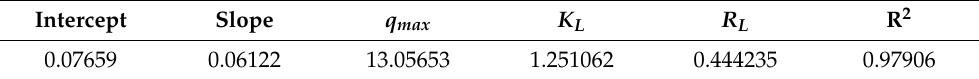
Table 6. Kinetic parameters of DR16 adsorption by B-ZnO/TiO 2